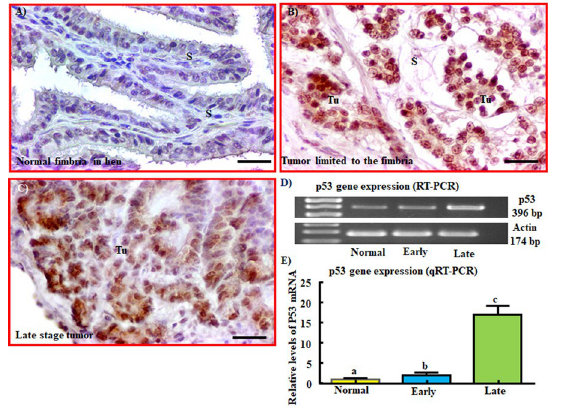
Fig 4. Detection of abnormality in p53 protein and gene expression in fimbriae with tumor in hens. A) Section of a normal fimbria in a hen. No staining for p53 is seen in normal fimbria. B and C) Section of a fimbria with tumor at early stage (B) and late stage (C) showing abnormal staining for p53. D) and E) Expression of p53 gene in normal fimbria and fimbria with tumor as detected by semi-quantitative (D) and quantitative (E) PCR (RT-PCR and qRT-PCR, respectively). Gene expression assays detected abnormal expression of p53 gene during malignant transformation which increased further as the tumor progressed to late stages ( P < 0.001). Fold change values are arbitrary values presented as mean ± SEM. Bars with different letters are significantly different. S = Stroma, Tu = Tumor. Scale bar = 20 μ m.